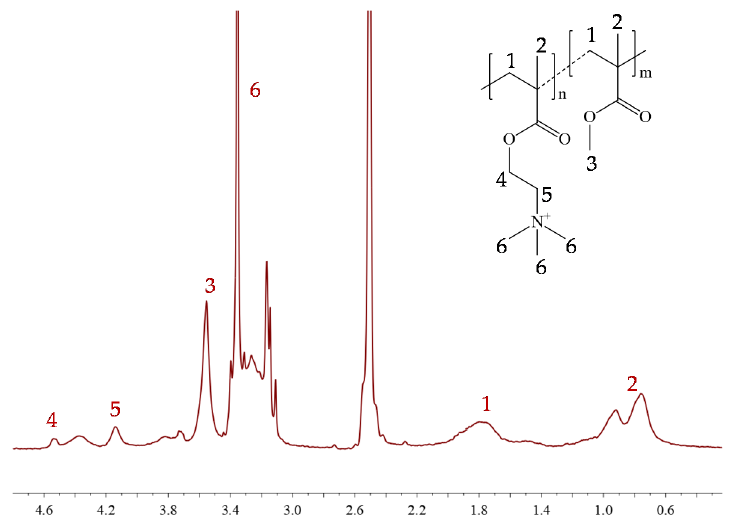
Figure 2. 1 H NMR spectrum of linear copolymer of TMAMA/Cl C1, where n is DP M1 and m is DP M2 .